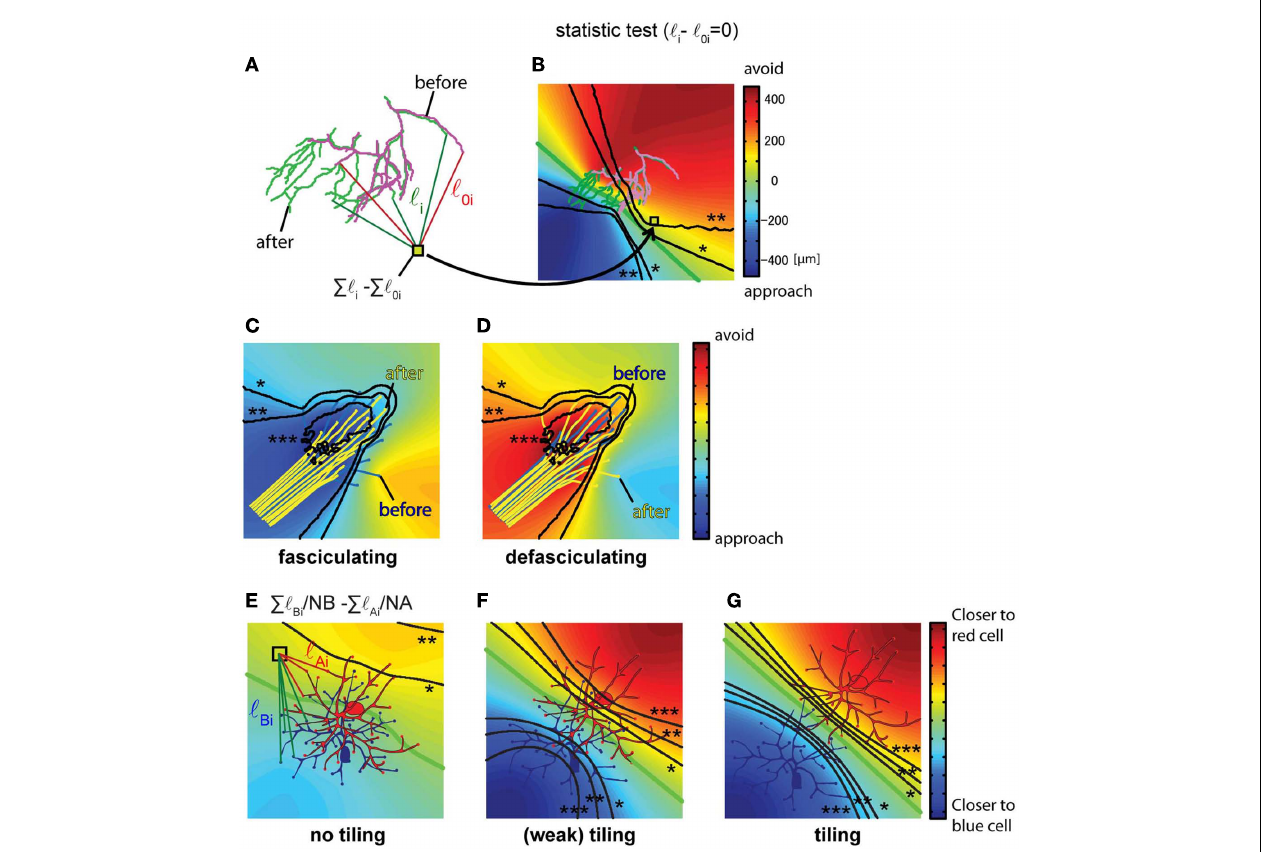
drawings of virtual data.When axons fasciculate, cold colors appear in the central position of the axon bundle, indicating that axon branches approach the main axon bundle (C) .When axons defasciculate, the axon bundle is embedded in warm colors, indicating the axons grow away from the fascicle (D) . p -Value contour lines, *0.05, **0.01, ***0.001 (E–G) . Quantification of dendritic tiling in three virtual cases showing different degrees of tiling superimposed on a displacement map.The formula, Σ l Bi /N B − Σ l Ai /N A , calculates the value for each pixel on the image corresponding to the sum of the distances from the pixel to each branch tip for the dendritic arbors of the blue and red neurons. N A and N B correspond to the number of dendritic branch tips in the red and blue neurons, respectively.The color map indicates the relative distance from each pixel to the dendrites of the red neuron and the blue neuron; hot colors indicate that branches are closer to the red neuron, cold colors indicate that branches are closer to the blue neuron.The green contour line is equidistant between the dendrites of the two neurons.The statistical significance of the difference between l A(i − j) /N A and l B(i − j) /N B is tested usingWelch’s t -test for each pixel. Contour lines show p -values of 0.05 (*), 0.01 (**) and 0.001 (***). (B) : 1 pixel = 1 μ m 2 . Maps are 336 μ m on each